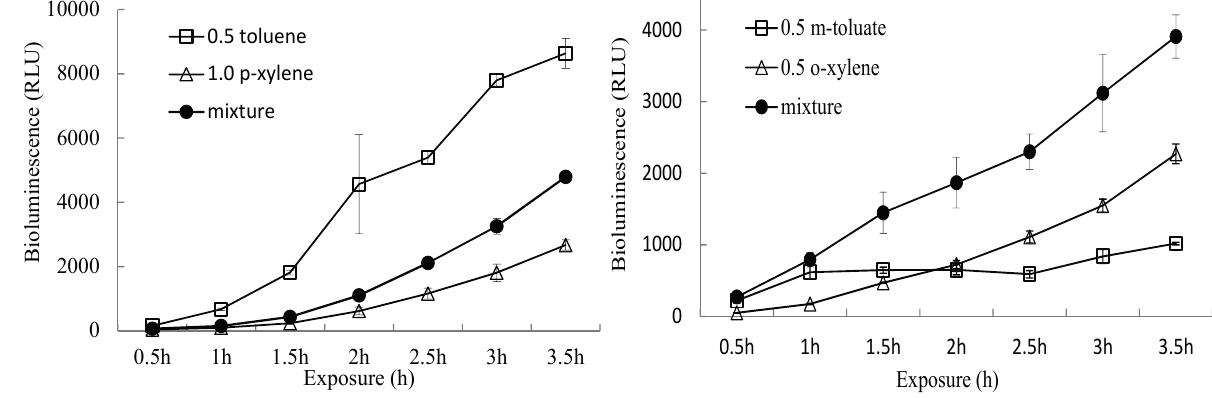
Figure 2. Two representative results of bioluminescence activity in the presence of single inducers and mixtures of binary inducers.